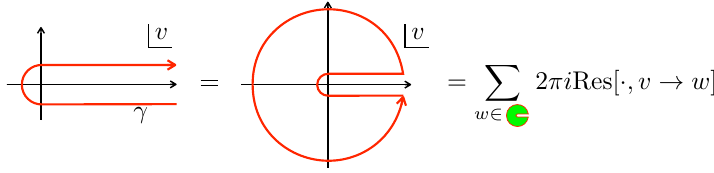
Figure 1 . Left: the integration contour γ used in the first line of (4.16); center and Right: deformation of the contour to derive the second line of